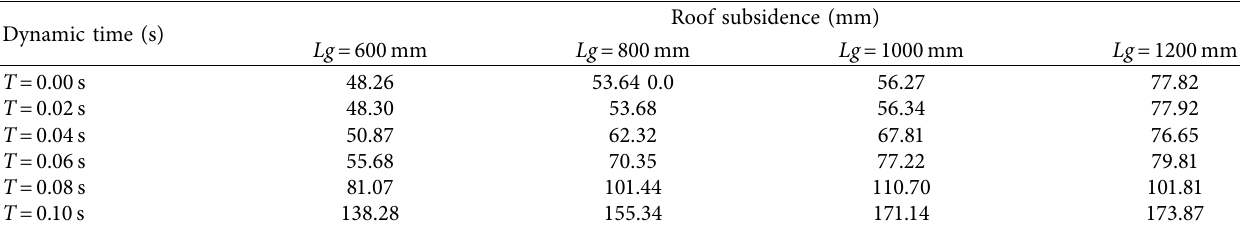
Table 12: Roof subsidence with different bolt